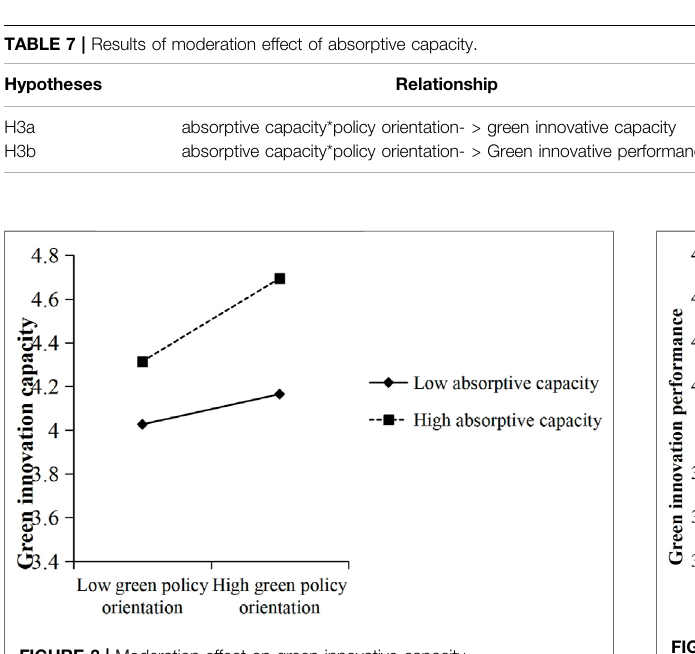
FIGURE 3 | Moderation effect on green innovative capacity. FIGURE 4 | Moderation effect on green innovative